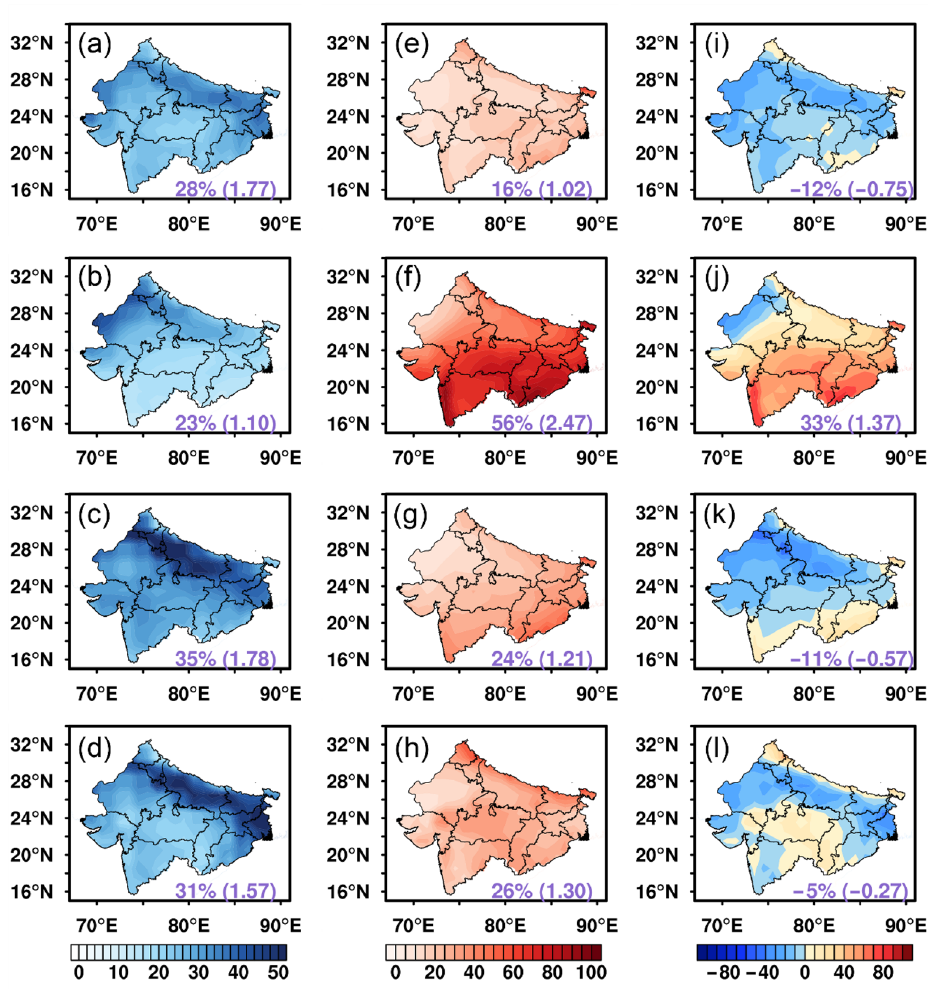
Figure 5. The same as Fig. 4, but for the NI. The map was generated by ESRI ArcGIS 10.5 software available at the ESRI website (https:// www. esri. com/ en- us/ arcgis/ produ cts/ arcgis- platf orm/ overv iew). The administrative boundary shapefile for northern India is available at the GADM website (https:// gadm. org/ downl oad_ count ry.